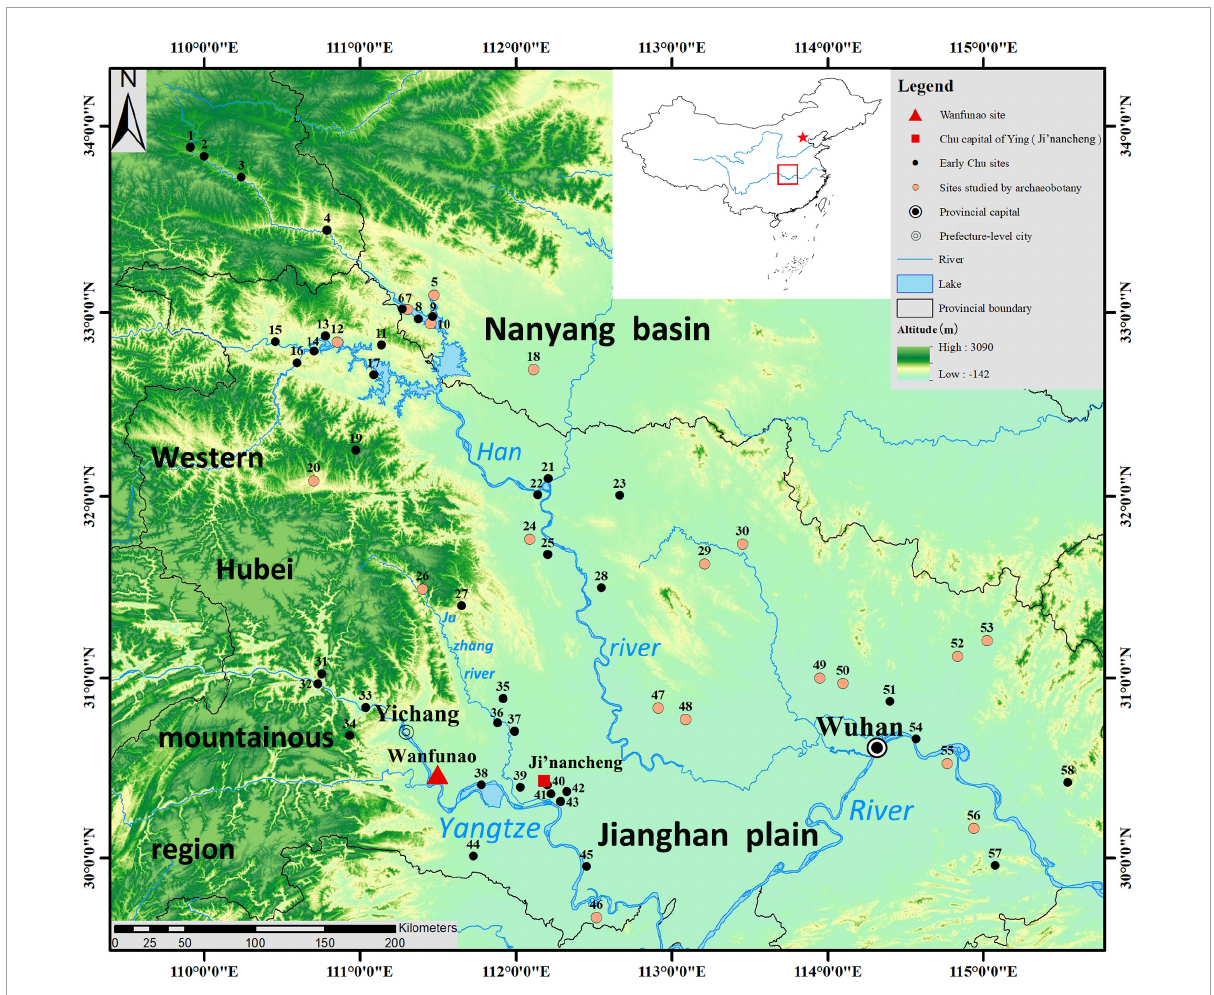
FIGURE1 Geographic distribution of the sites of early Chu culture and other related sites studied by archeobotany. (1) Chenyuan, (2) Zijing, Donglongshan, (3) Gongjiawan, (4) Guofenglou, (5) Gouwan, (6) Xiazhai, (7) Shenmingpudong, (8) Shangang, (9) Shuanghezhen, (10) Xiawanggang, (11) Xiajiao, (12) Qinglongquan, Dasi, (13) Qujiawan, (14) Liaowadianzi, (15) Zhongtaizi, (16) Dadongwan, (17) Zhujiatai, (18) Baligang, (19) Sunjiaping, (20) Jijiawan, (21) Xiaojialing, (22) Zhenwushan, (23) Maogoudong, (24) Huanggang, Xiajiangjiabianzi, (25) Guojiagang, (26) Mulintou, (27) Lujiahe, (28) Liuhe, (29) Jizibao, Zhoujiabang, (30) Miaotaizi, Zhoujiazhai, (31) Guanzhuangping, (32) Miaoping, (33) Huangtubao, Tanjiatuo, Xiaoxikou, Shangmonao, (34) Jijiahu, (35) Yangmugang, (36) Fengshan, (37) Fujiayao, Mopanshan, Zhaojiahu, (38) Hejiawa, (39) Meihuaiqiao, (40) Motianling, (41) Zhangjiashan, (42) Yangcha, (43) Zhouliangyuqiao, (44) Boyushan, (45) Jingnansi, (46) Zoumaling, (47) Qujialing, (48) Sanfangwan, Tanjialing, (49) Zhengjiadamiao, Yejiamiao, (50) Chenghuangdun, (51) Lutaishan, (52) Jinluojia, (53) Lishangang, (54) Xianglushan, (55) Chengzishan, (56) Xiezidi, (57) Heshangnao, and (58)